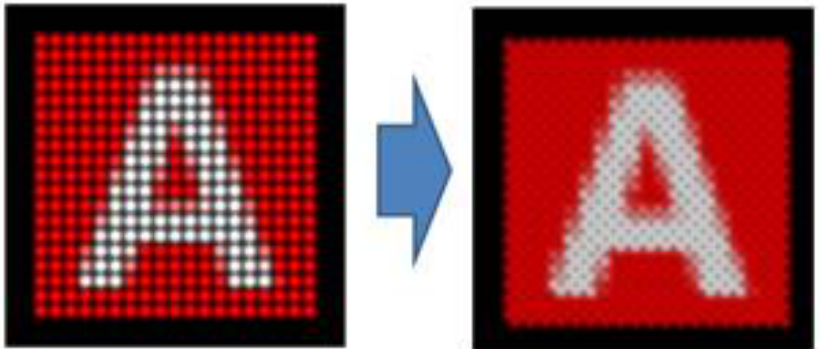
Figure 1. Micro-scan compensation technology enhances the pixels.